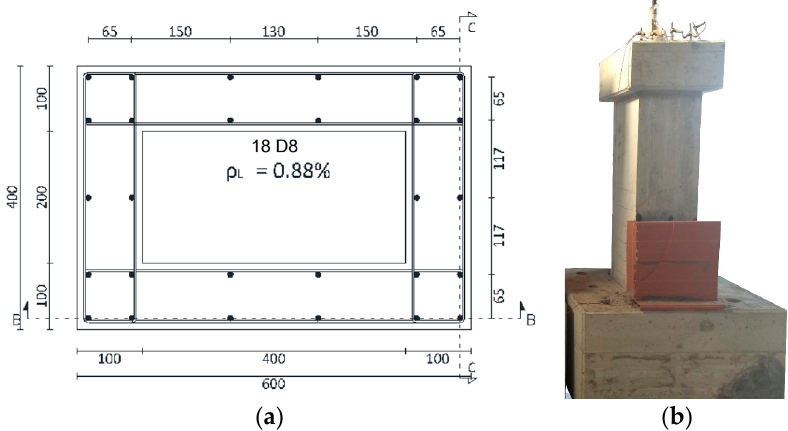
Figure 1. ( a ) Cross section (dimensions in mm) and ( b ) view of rectangular hollow pier with sodium chloride solution tank.